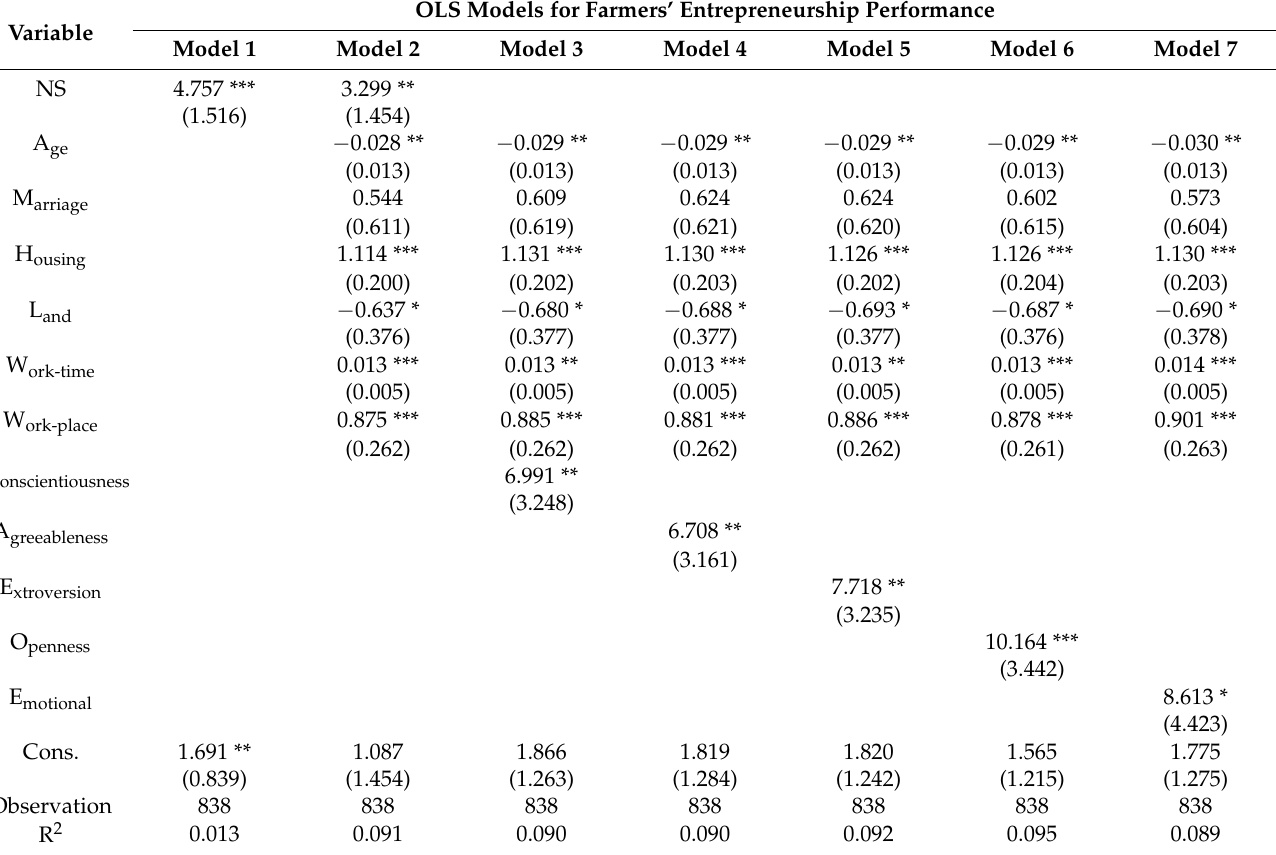
Table 3. Non-cognitiveskillsandfarmers’entrepreneurshipperformance: theresultsofbenchmark